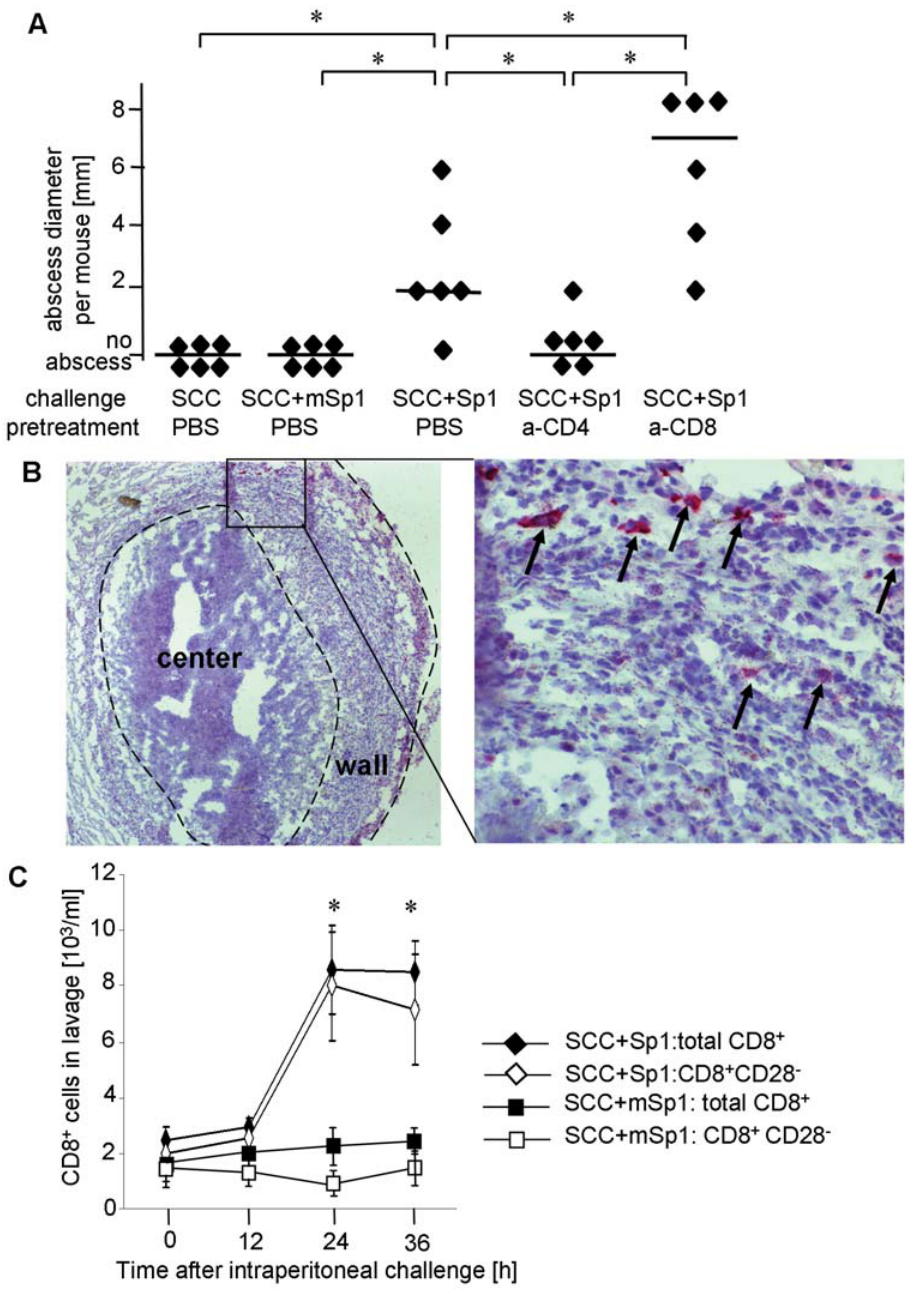
Figure 1. CD8 + T cells modulate abscess formation in response to intraperitoneal Sp1-application. A. C57BL/6 WT mice received an anti- CD4-mAb, an anti-CD8-mAb, or PBS intravenously 24 h prior to intraperitoneal Sp1-challenge, or challenge with chemically modified Sp1 (mSp1) plus sterile cecal content (SCC) adjuvant, or SCC alone as controls. After 6 days, examination for intraperitoneal abscess formation was performed at autopsy. Each dot represents the abscess diameter per mouse; bars indicate the median abscess size per group; *p , 0.05. The experiment was performed three times independently with 6 mice per group, respectively. One representative experiment is shown in the figure. B. Immunohistochemistry of Sp1-induced abscesses was performed with an anti-CD8-mAb. The left panel shows an overview of an abscess. The right panel shows the magnified detail of the abscess wall within the rectangular box of the left panel. Some CD8 + T cells are labeled with black arrows. The figures show one representative result out of three experiments. C. The influx of CD8 + and CD8 + CD28 2 T cells into the peritoneum was determined in C57BL/6 mice challenged with Sp1 or mSp1 plus SCC as a control. The peritoneal lavage was performed at different time intervals (x-axis) after challenge. Cell numbers were determined by cell counting and flow cytometry. Bars indicate standard deviations within a tested group; *p , 0.05. The experiment was performed two times with each 4 mice per group and time point. The figure shows one representative result.